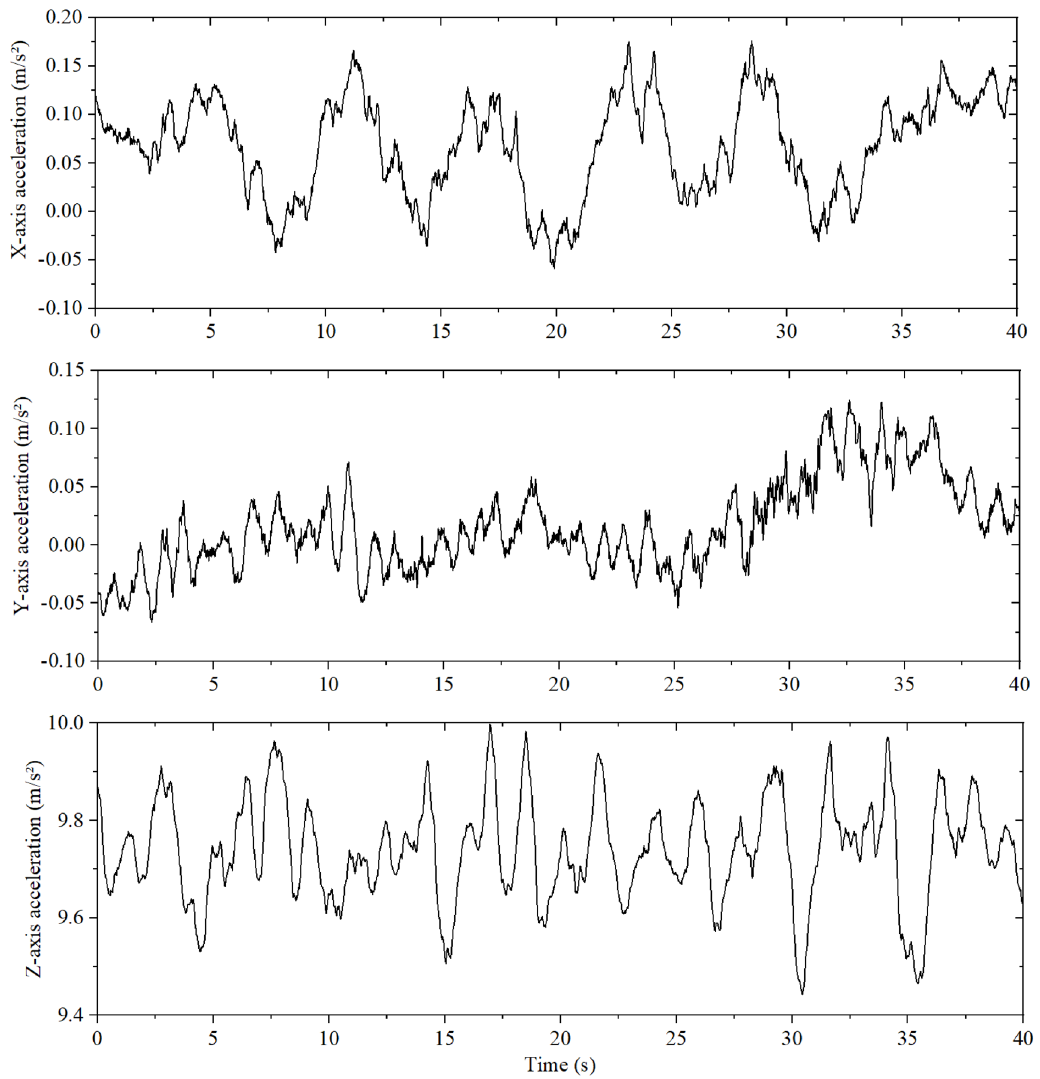
Figure 19. Acceleration variation of flight platform during dual-arm reciprocating swing.